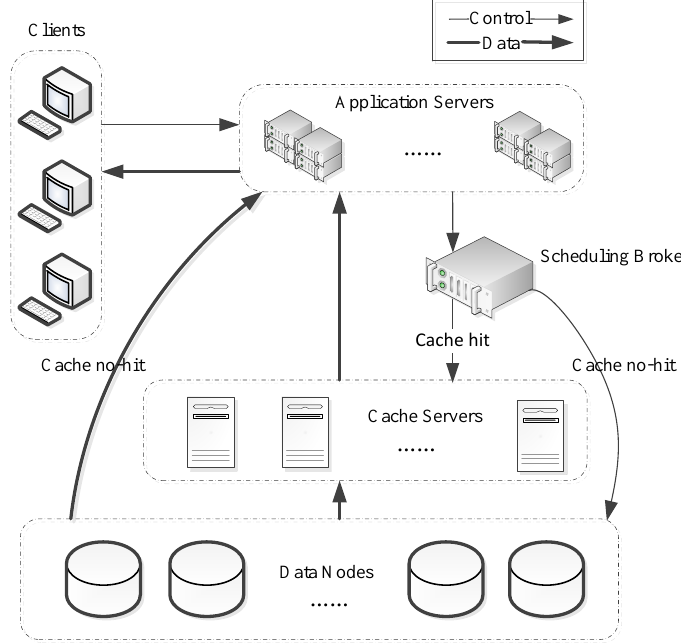
Figure 1. Application service system architecture of smart city.